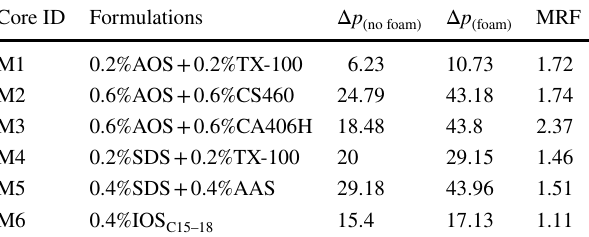
Table 8 MRF result of surfactant formulations at reservoir conditions Core ID